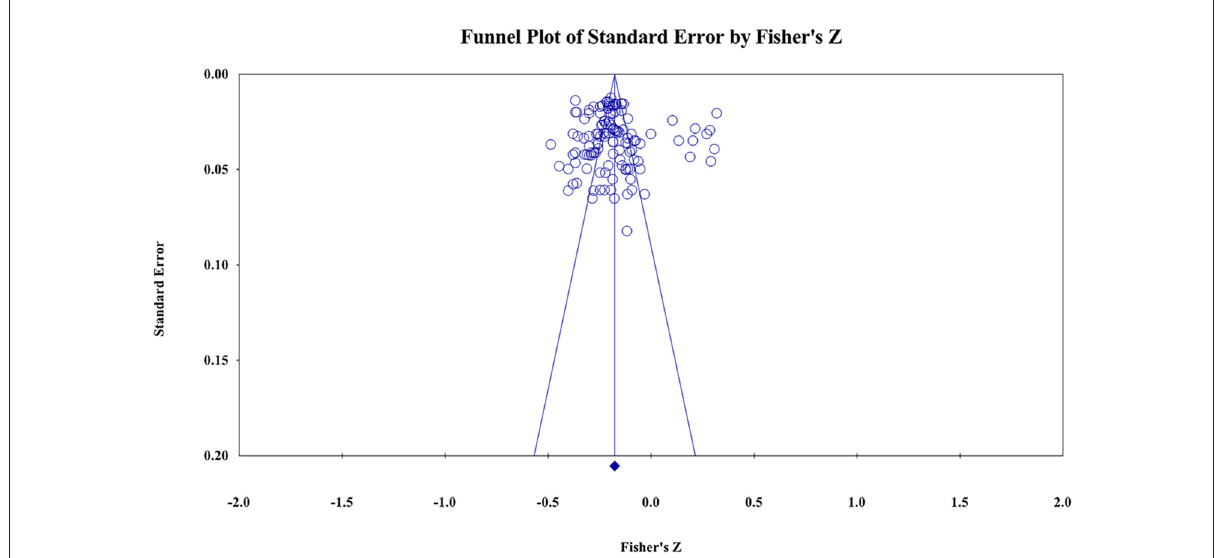
FIGURE3 Funnel plot of effect sizes of the correlation between parent-child relationship and PIU.